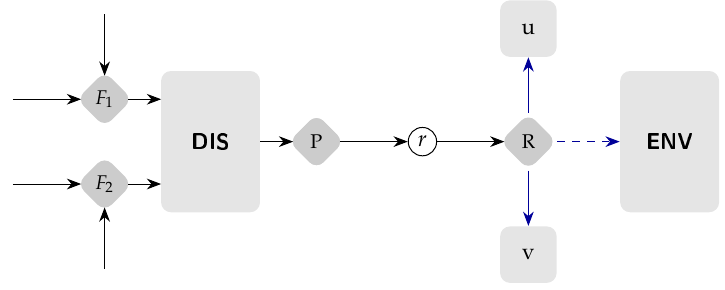
Figure 5. Waste allocation scheme in the productive structure of a